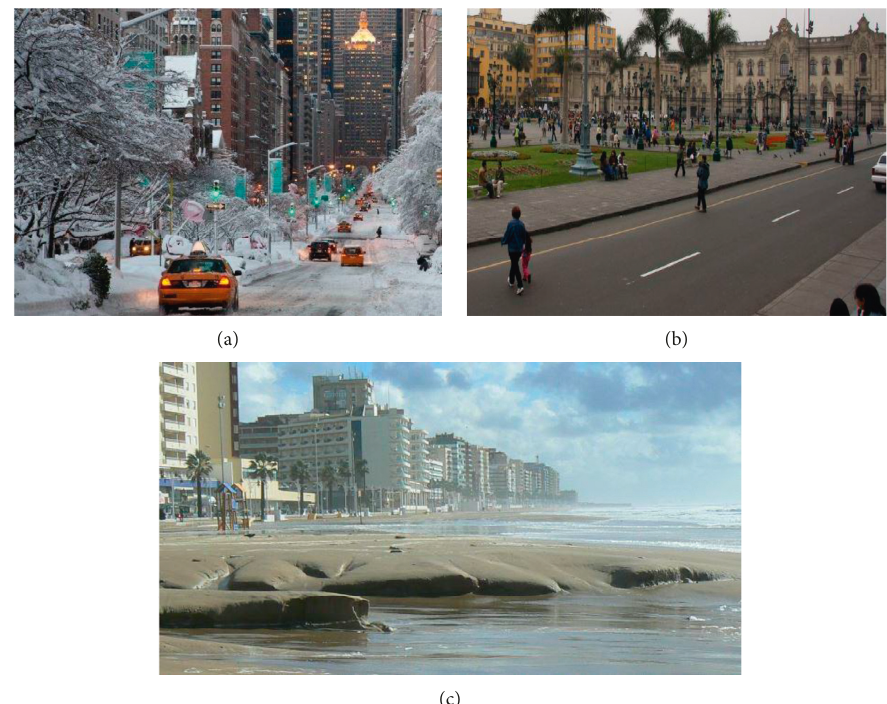
Figure 2: Various environment conditions for a traffic signal controller: (a) low temperature; (b) high temperature; (c) coastal